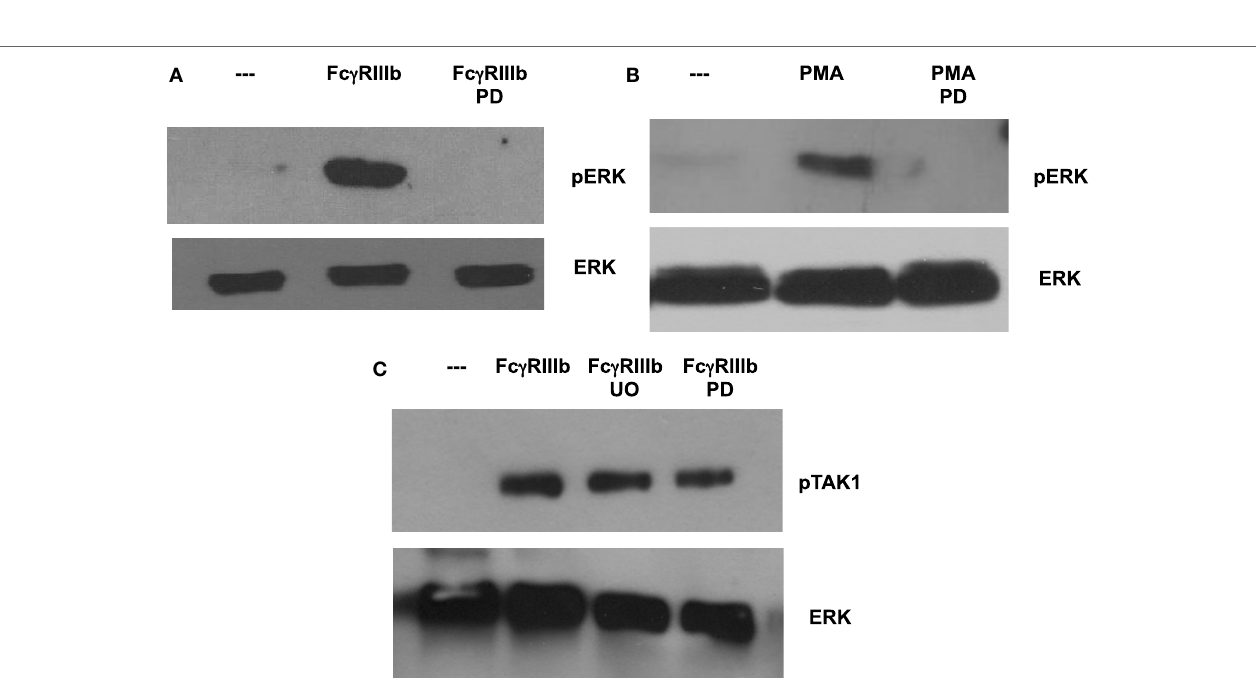
FigUre 7 | MeK1 is required for Fc γ riiib-mediated erK activation . Human neutrophils were left untreated (---), or were stimulated by cross-linking Fc γ RIIIb for 15 min, or by 20 nM phorbol 12-myristate 13-acetate (PMA). Some neutrophils were previously treated with 50 μ M PD98059 (PD) or with 50 μ M UO126 (UO), both selective inhibitors of MEK. Cell lysates were prepared after stimulation. Proteins were resolved by SDS-PAGE, and then Western blotted for (a,B) phosphorylated ERK (pERK) (upper panel) and for total ERK (lower panel); or for (c) phosphorylated-TAK1 (pTAK1) and for total ERK (lower panel). Data are representative of three separate experiments.